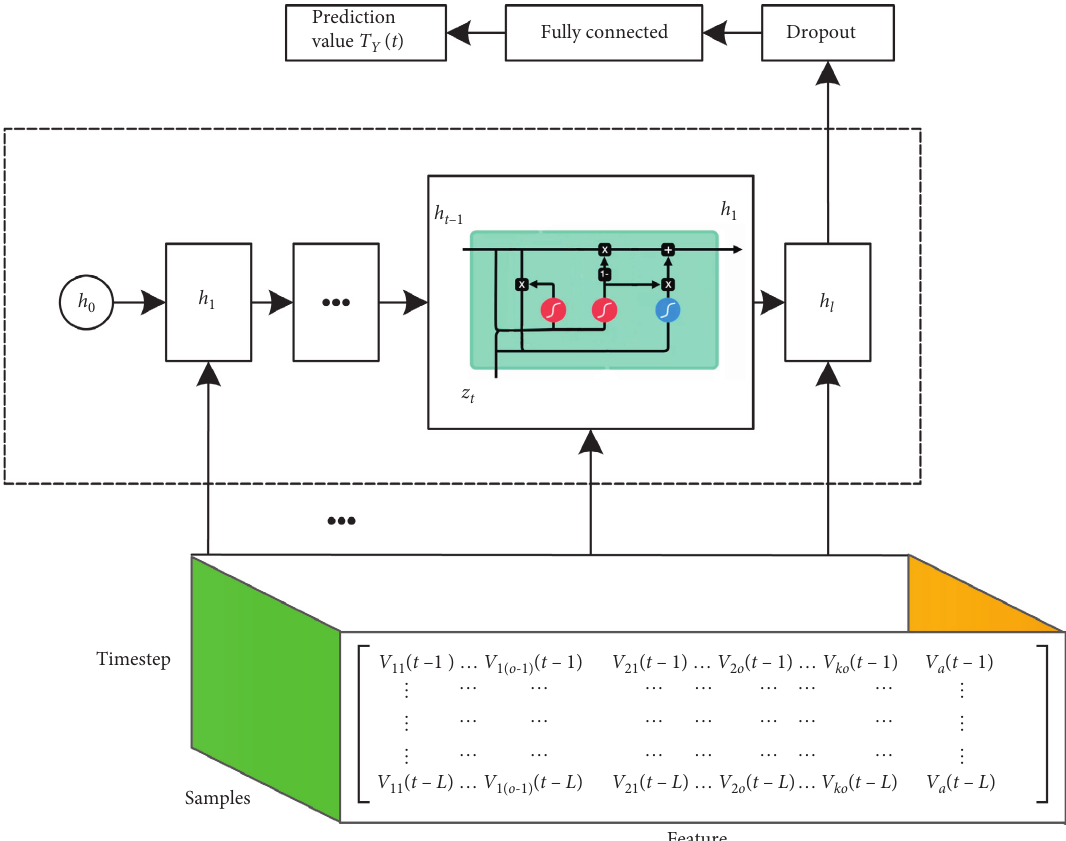
Figure 2: GRU algorithm